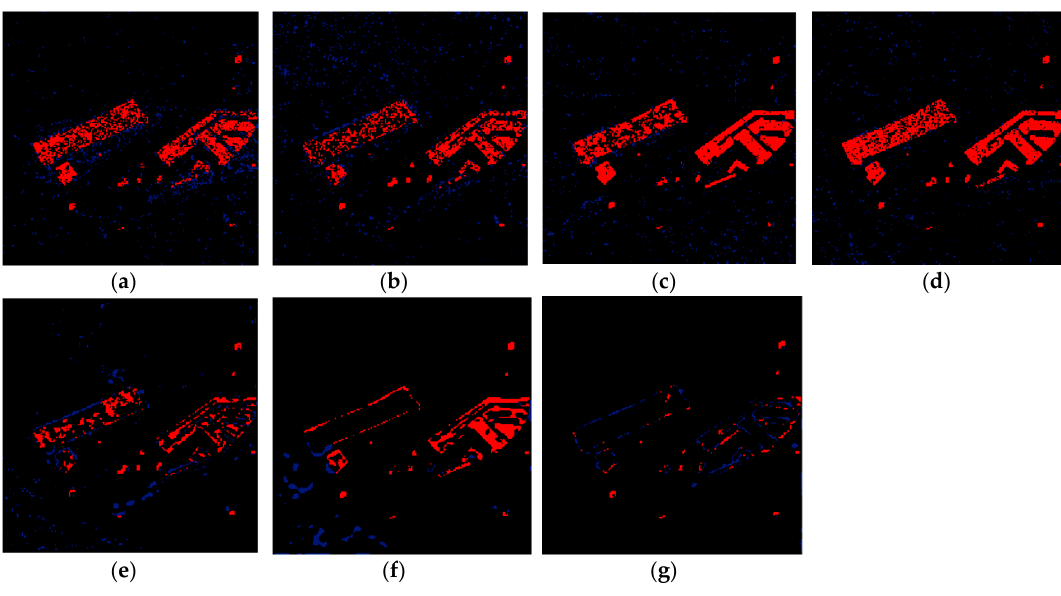
Figure 22. The errors in change detection of di ff erent methods for the PolSAR-San Francisco1 dataset. ( a ) CVA-SVM, ( b ) MAD-SVM, ( c ) PCA-SVM, ( d ) IR-MAD -SVM, ( e ) SFA-SVM, ( f ) 3D-CNN, and ( g ) Proposed Method. Black, red, and blue colors indicate TN and TP, FN, and FP pixels, respectively.